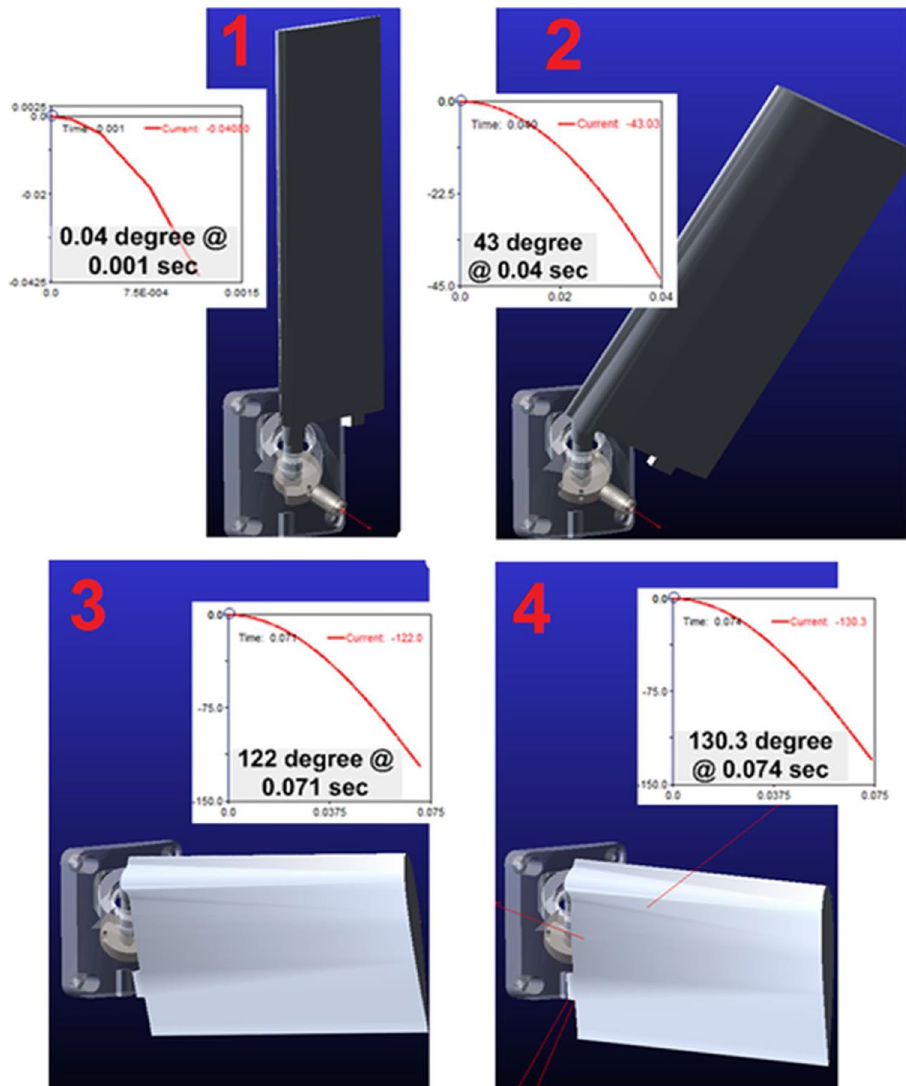
Figure 7. Dynamic simulation of the mechanism from folded to the deployed